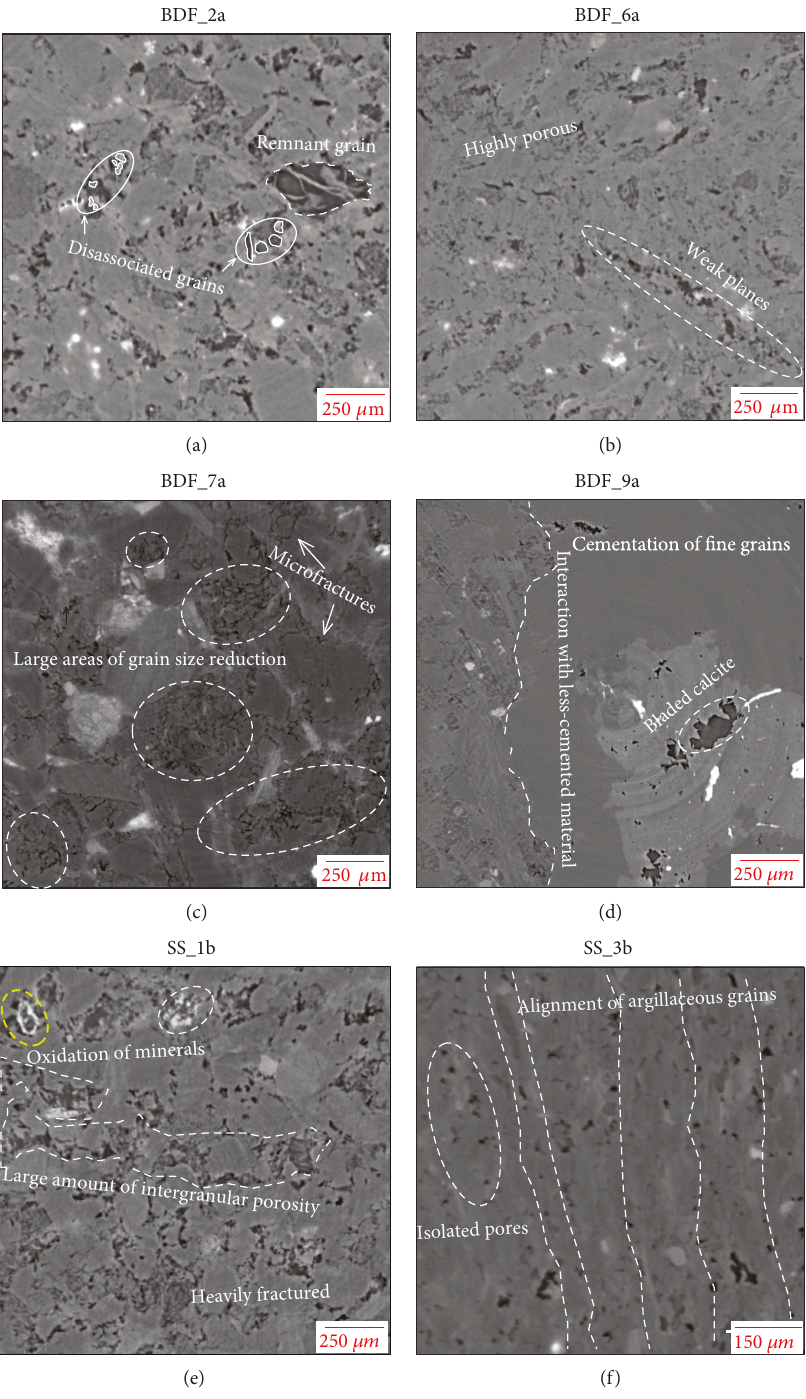
Figure 12: X-ray microCT images of some analyzed fault cores: (a) BDF_2a, sand-rich and a ff ected by dissolution, (b) BDF_6a; silty sand fault core a ff ected by both microfracturing and dissolution, (c) BDF_7a; sand-rich a ff ected both microfracturing and dissolution, (d) BDF_9a; highly cemented sample, (e) SS_1b; sand-rich fault core highly a ff ected by dissolution and microfracturing, and (f) SS_3b; clay-rich fault core with evidence of grain alignment. Description of the samples in Table